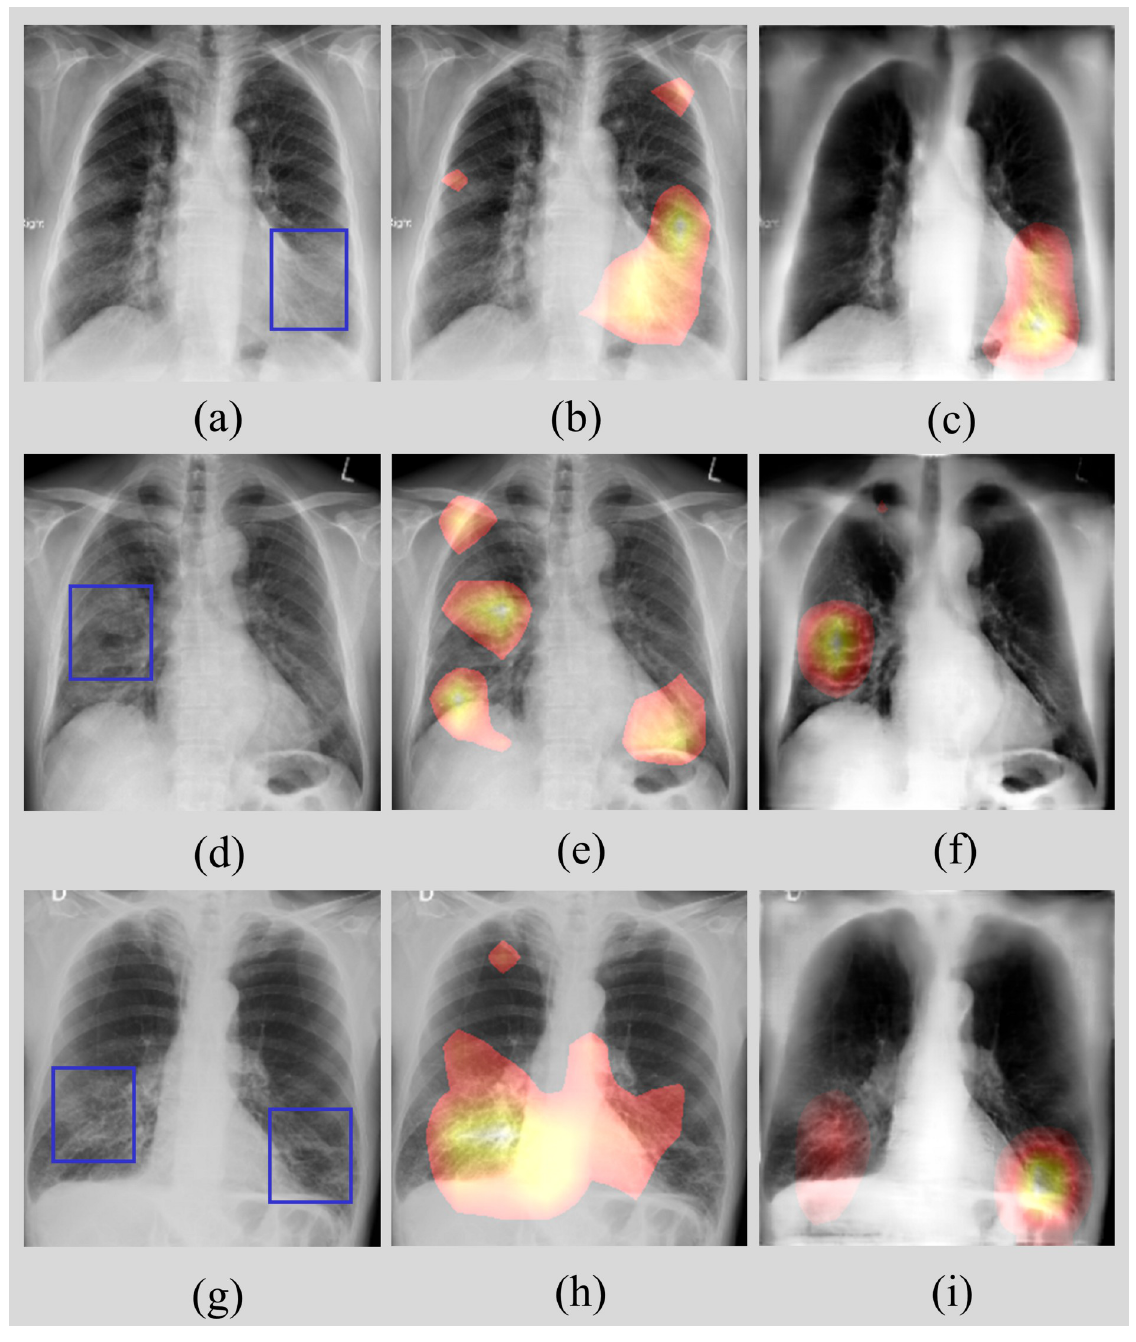
Fig 10. CRM-based localization of COVID-19-consistent manifestations. (a) (d) and (g) denote instances of CXRs from the Twitter COVID-19 CXR collection showing COVID-19-manifestations with expert annotations (shown with blue bounding boxes); (b) (e) and (h) shows the regions highlighted by the model trained on non-bone-suppressed images; (c) (f) and (i) shows the COVID-19-consistent ROIs highlighted by the model trained on bone-suppressed